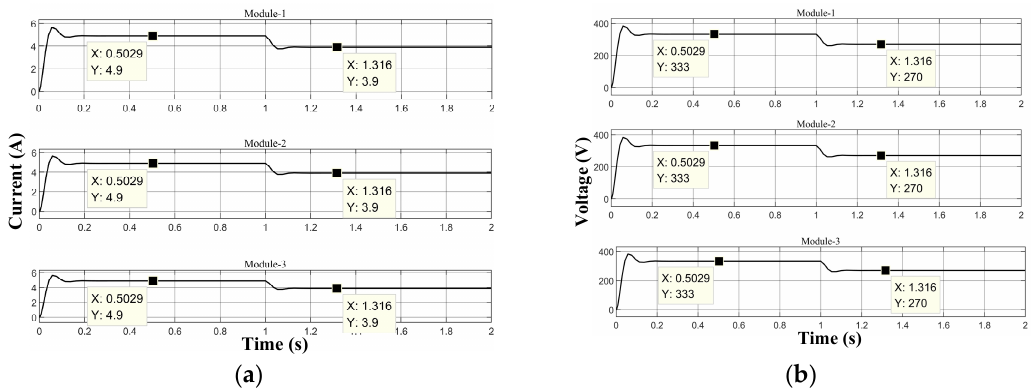
Figure 8. Simulation results of combined converter 1 under condition 1: ( a ) input current of the modules and ( b ) output voltage of the modules.